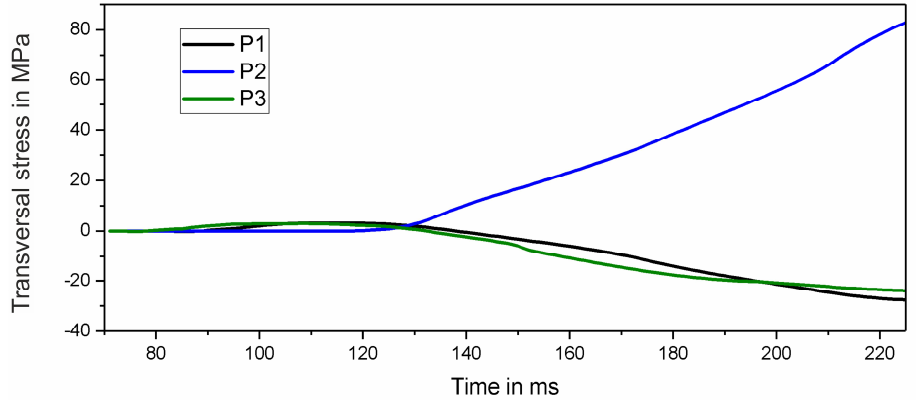
Figure 15. Transversal stress evaluation on the points P1, P2, and P3.